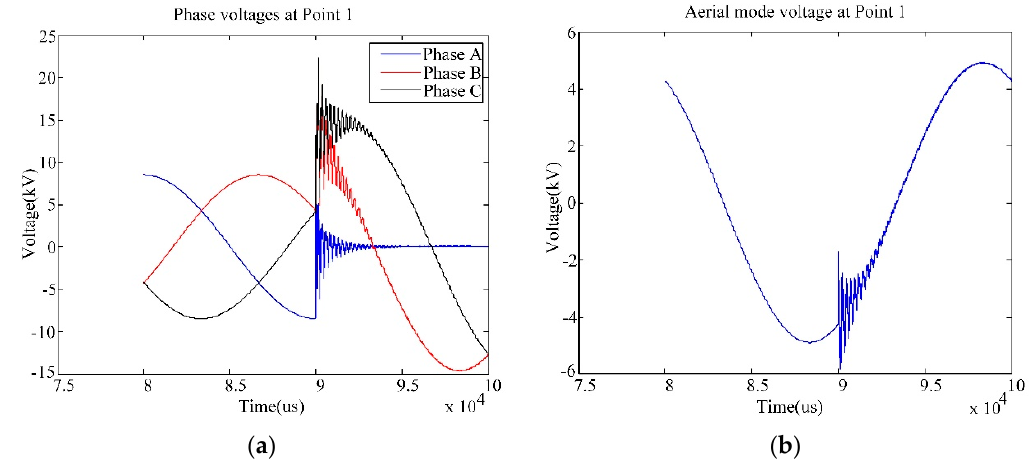
Figure 5. Phase and aerial-mode voltages measured at point 1, ( a ) phase voltages, and ( b ) the aerial-mode voltage.